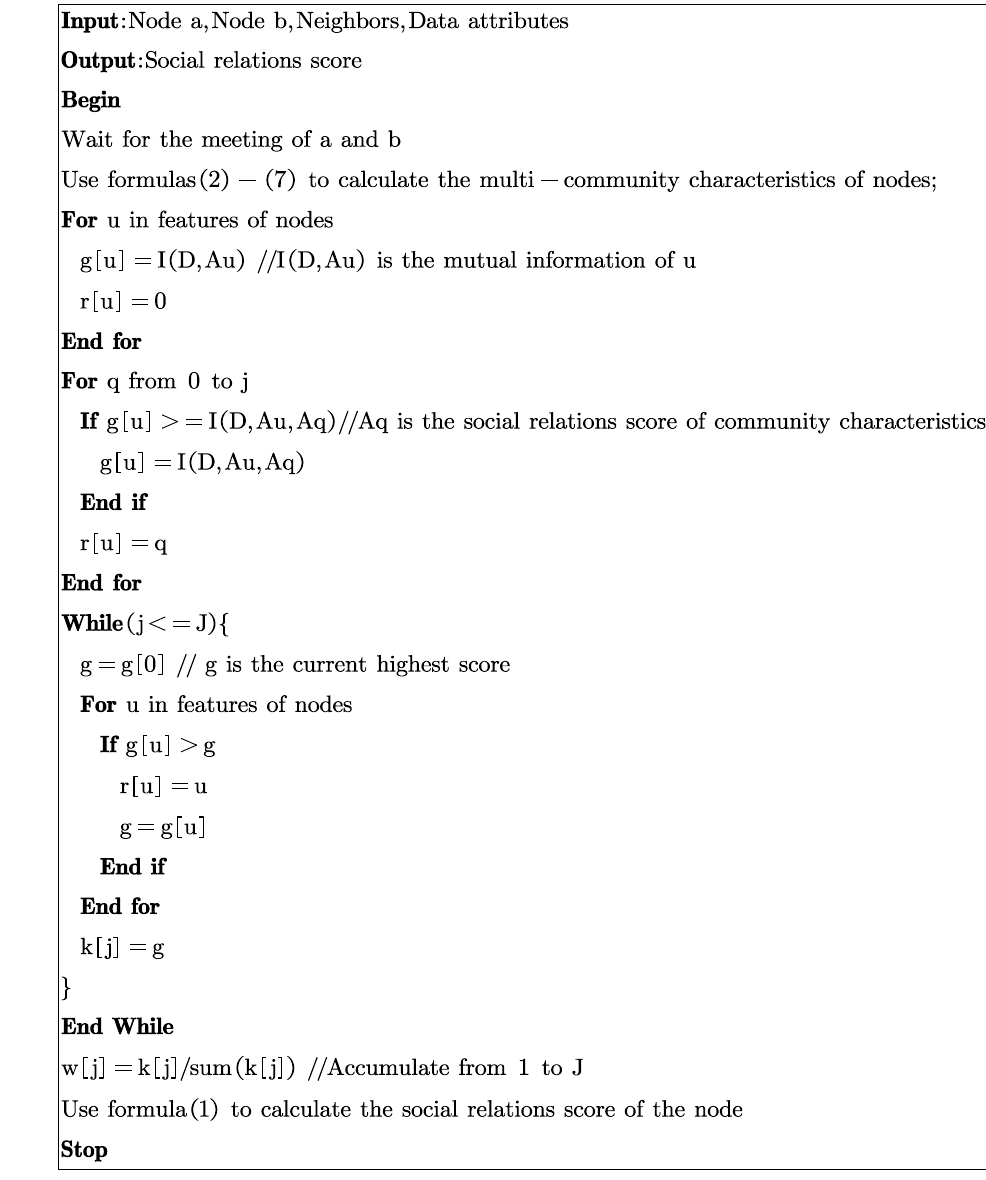
Figure 2. Algorithm.